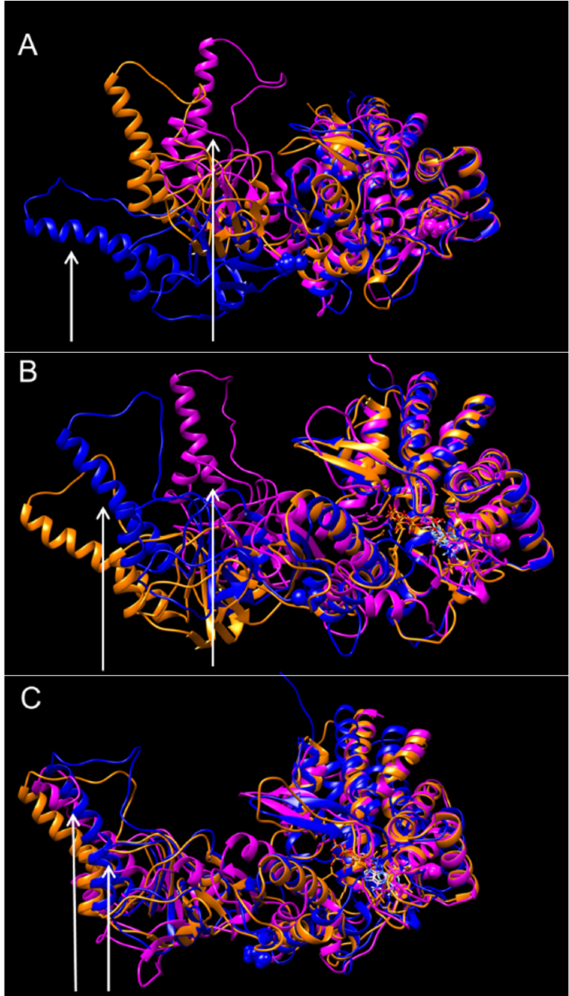
Figure 1. Predicted protein conformations of CCT5 wild type (orange), His147Arg mutant (lilac), and Leu224Val mutant (blue). Shown are the overlays of the most probable conformations obtained from the molecular dynamics simulation of the three proteins. ( A ) nucleotide free; ( B ) ATP-bound; ( C ) ADP-bound. The images show that the mutant proteins have different conformations than the wild type, especially under nucleotide-free and ATP-bound conditions, with the apical domain being the most affected. Arrows indicate the apical domain of the mutant proteins His147Arg (lilac), and Leu224Val